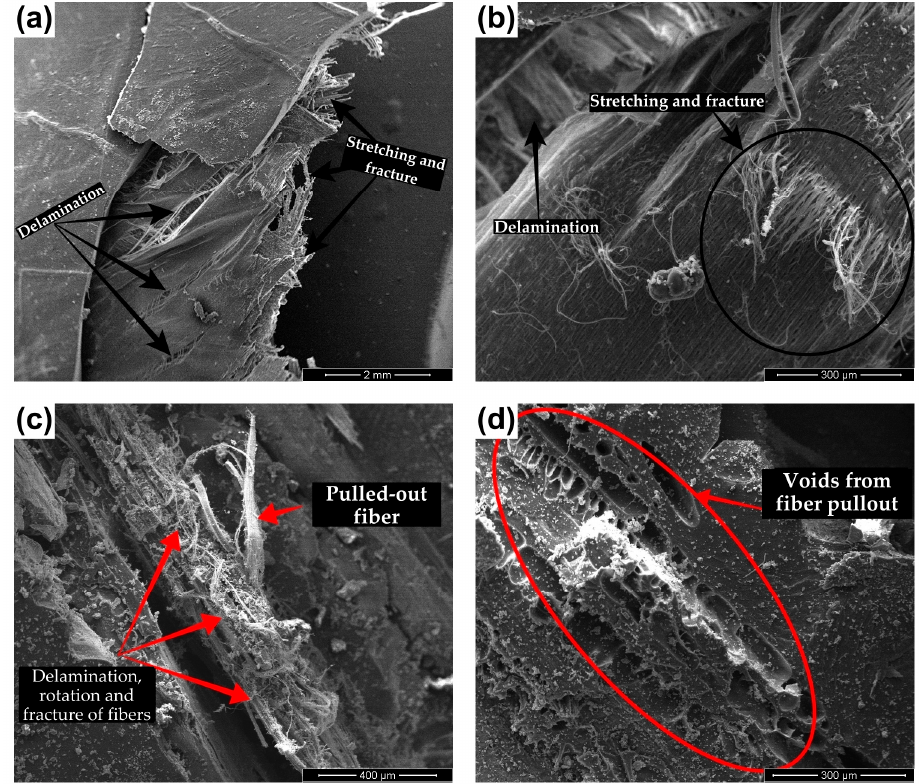
Figure 12. SEM images showing the different energy absorption mechanisms from the arapaima scales: ( a , b ) delamination, stretching and fracture of fibers from external layers; ( c , d ) rotation of fibers and fiber pullout.